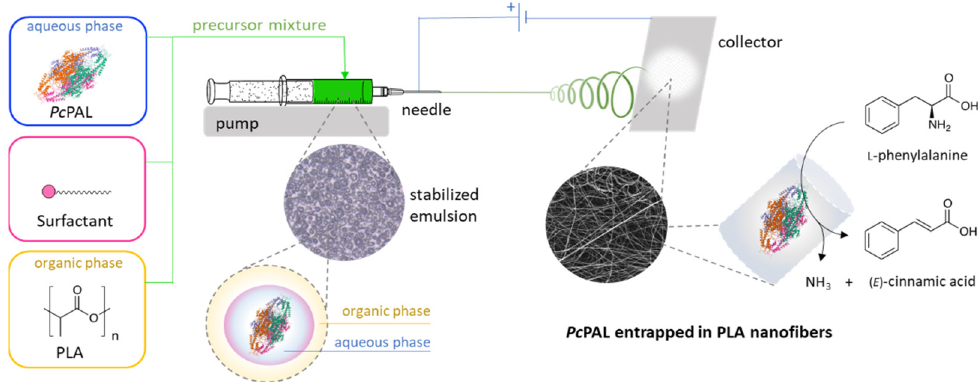
Figure 2. Entrapment of Pc PAL in PLA nanofibers by emulsion electrospinning.